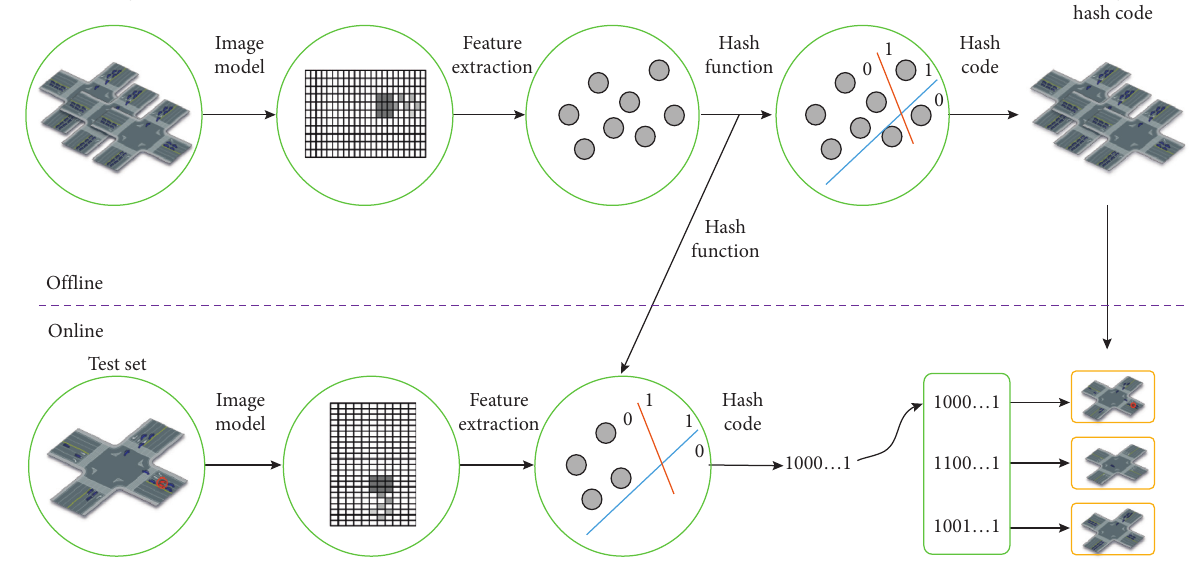
Figure 7: Traffic state recognition structure at the